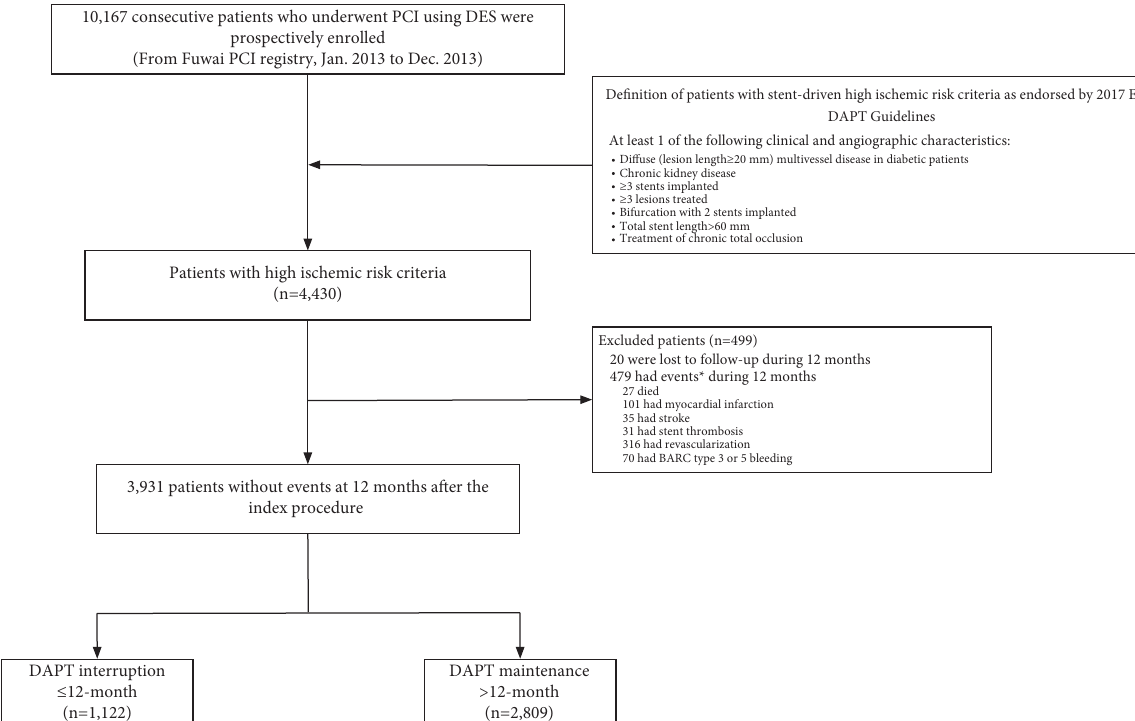
Figure 1: Study flow diagram. BARC � Bleeding Academic Research Consortium; DES � drug-eluting stent; DAPT � dual antiplatelet therapy; ESC � European Society of Cardiology; HIR � high ischemic risk; and PCI � percutaneous coronary intervention. ∗ Subjects may have > 1 event.